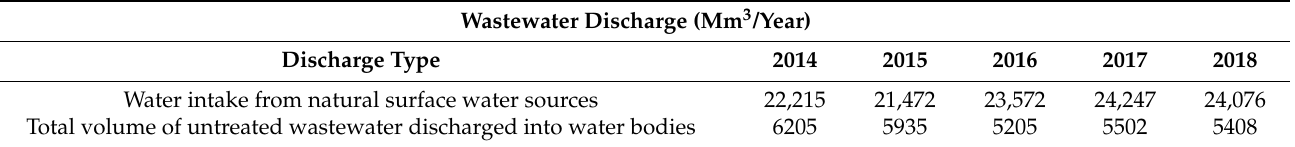
Table 1. Wastewater discharge into the Ishim River